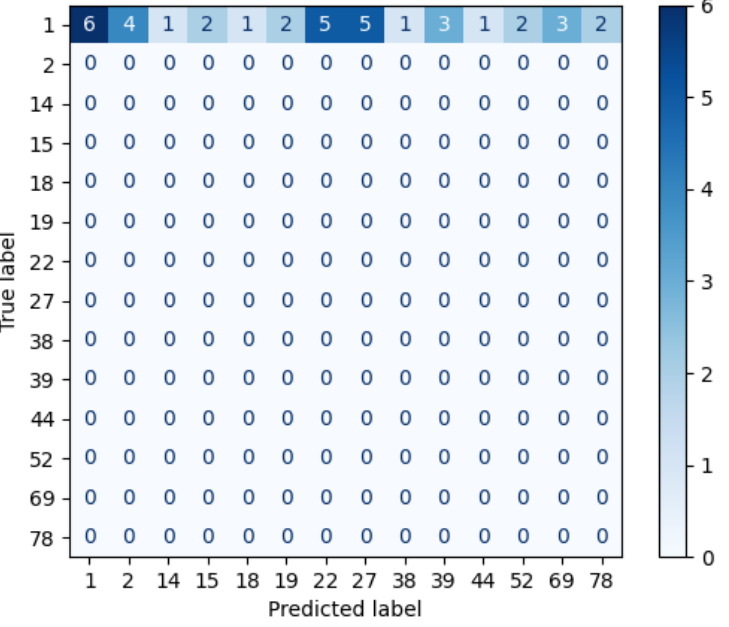
Figure 8. Example of confusion matrix obtained after the classification of layer 1.